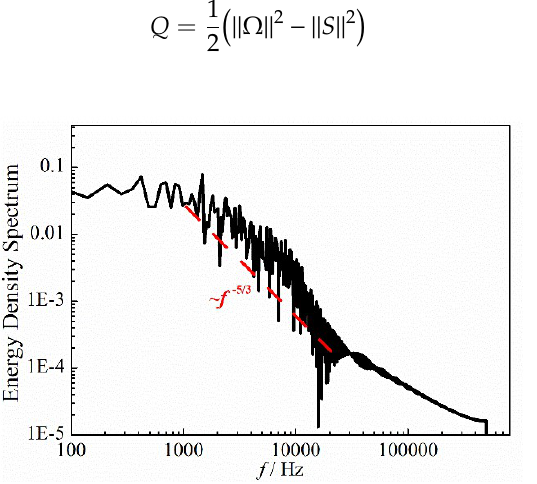
Figure 5. Plot of Energy Density Spectrum. The largest eddies (lowest frequencies) on the left side of the spectrum gained energy from the mean flow and the energy cascades down to smaller eddies (larger frequencies) until it is dissipated.